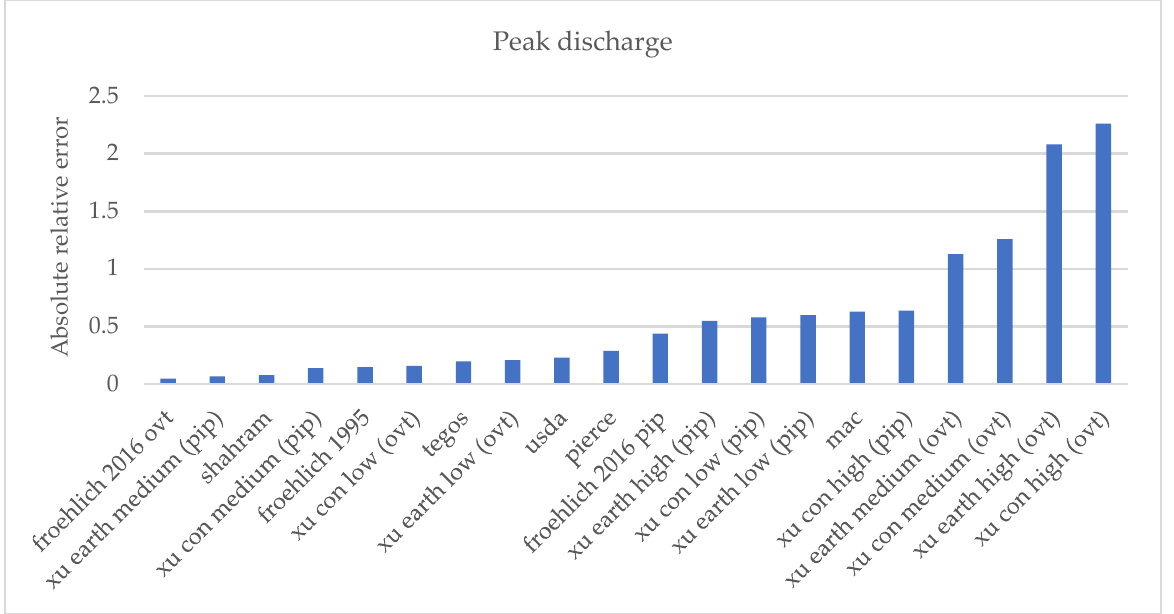
Figure 13. The absolute relative errors for the empirical formulas calculated for the peak discharge.